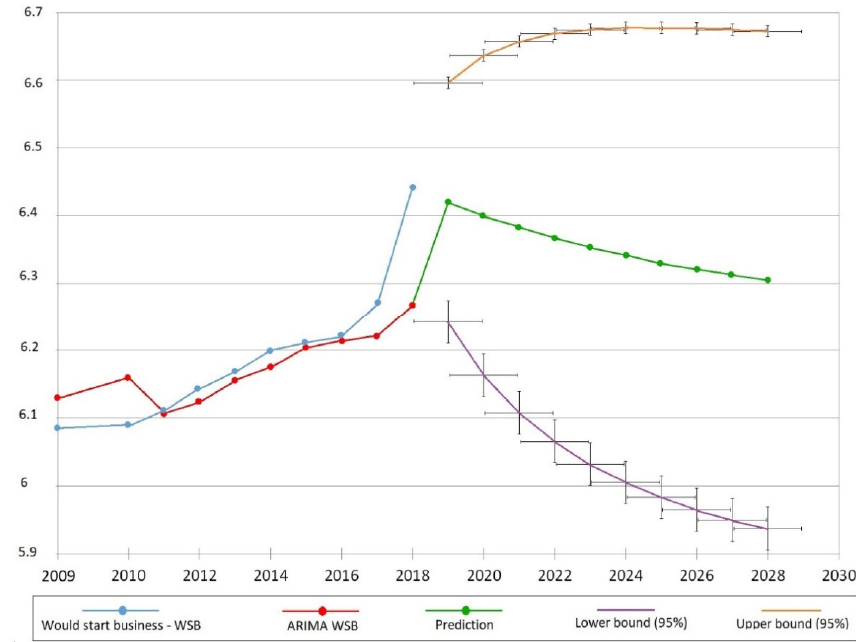
Figure 1. ARIMA forecasting graph (includes all the predictors).